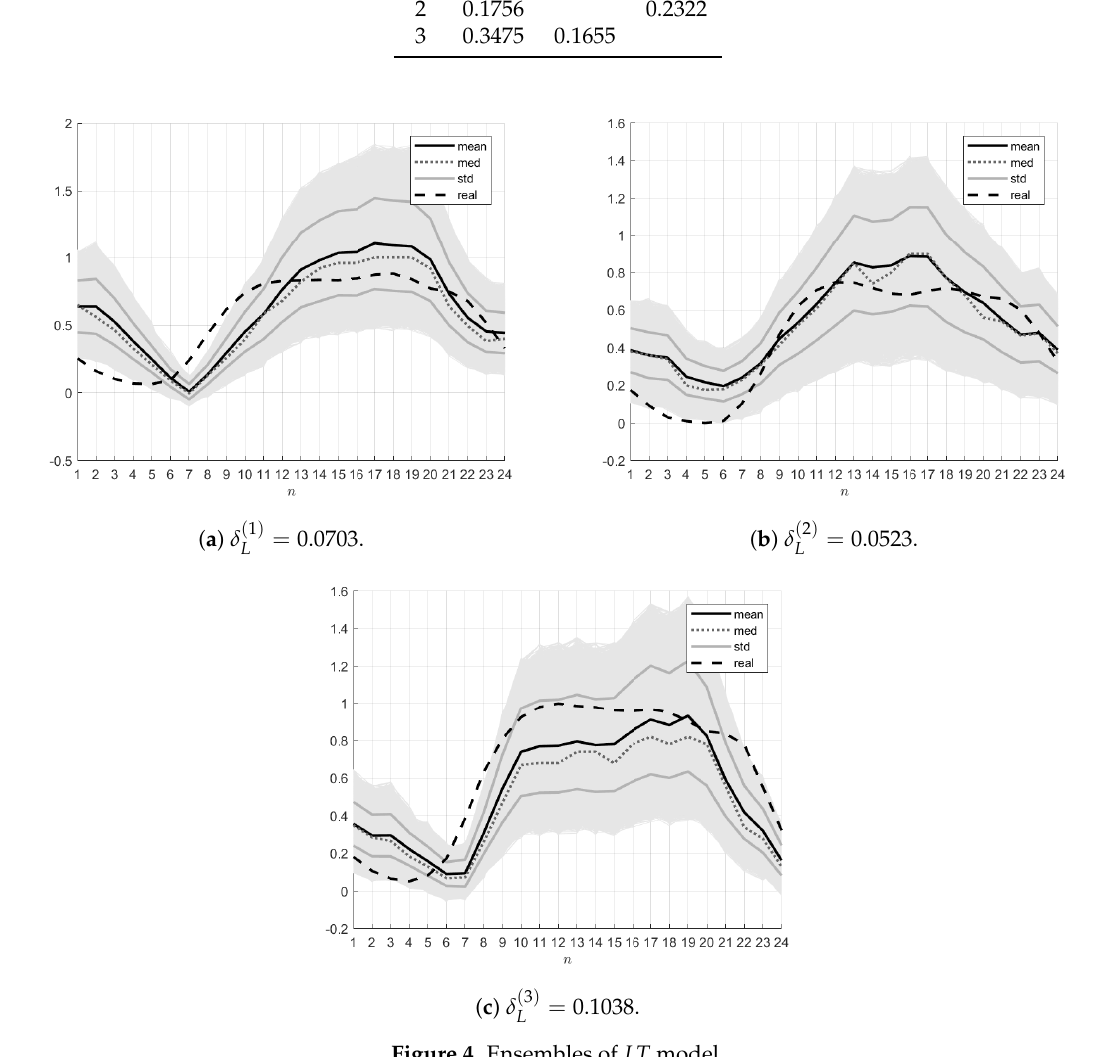
Figure 4. Ensembles of LT